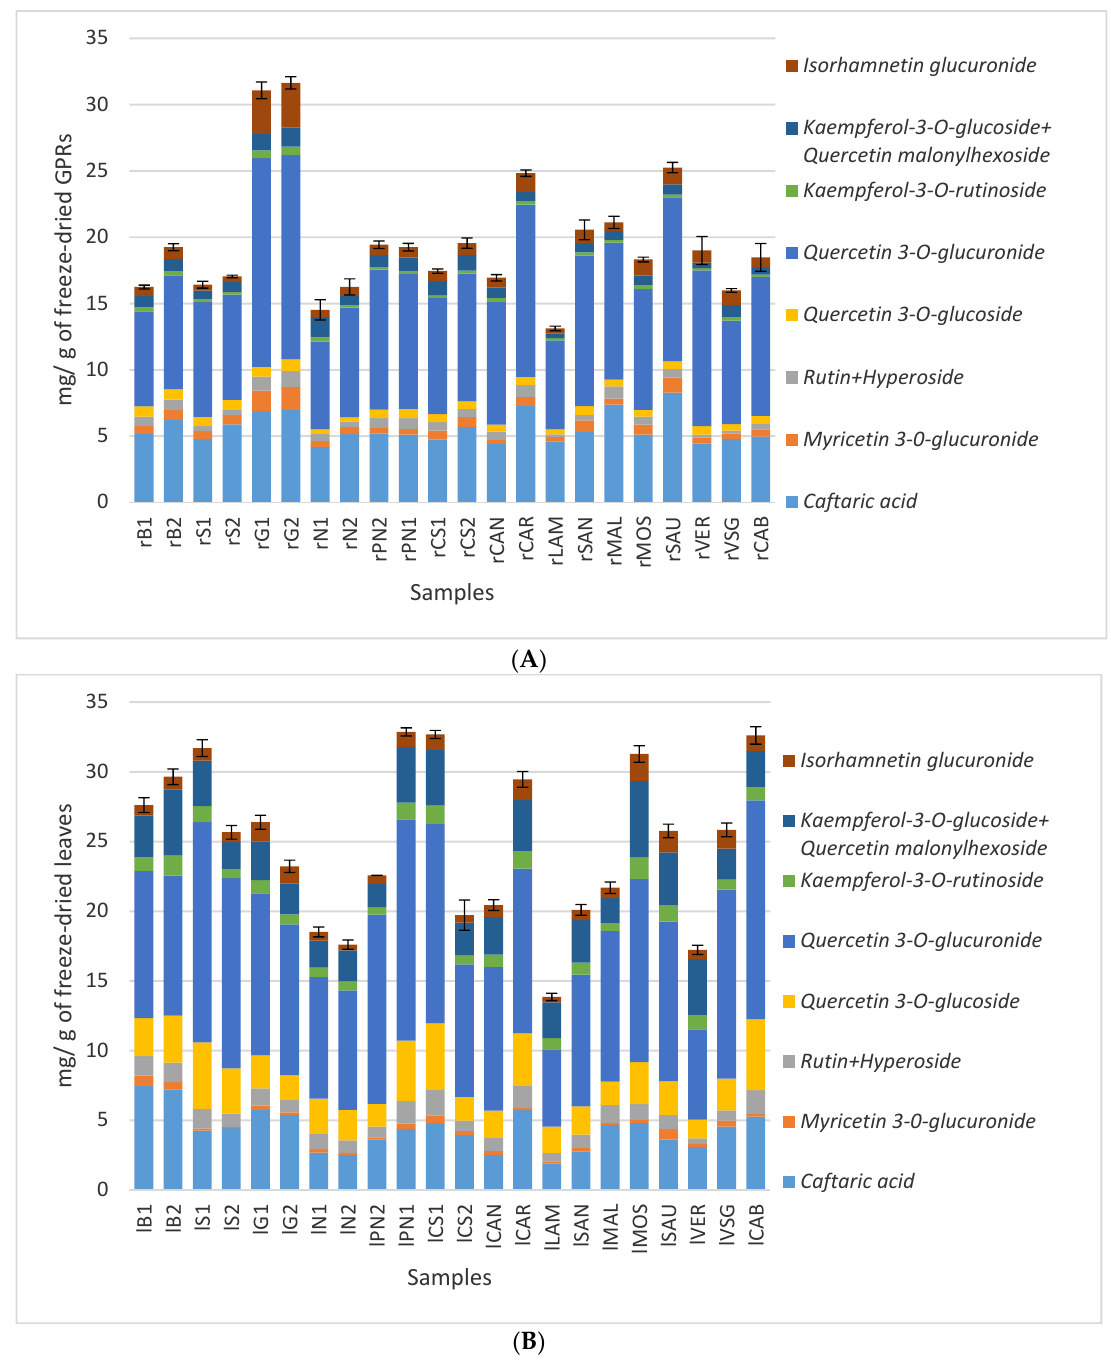
Figure 2. Concentration (mg / g) of the main phenolic compounds of freeze-dried green pruning residues (GPRs) ( A ) and leaves ( B ).